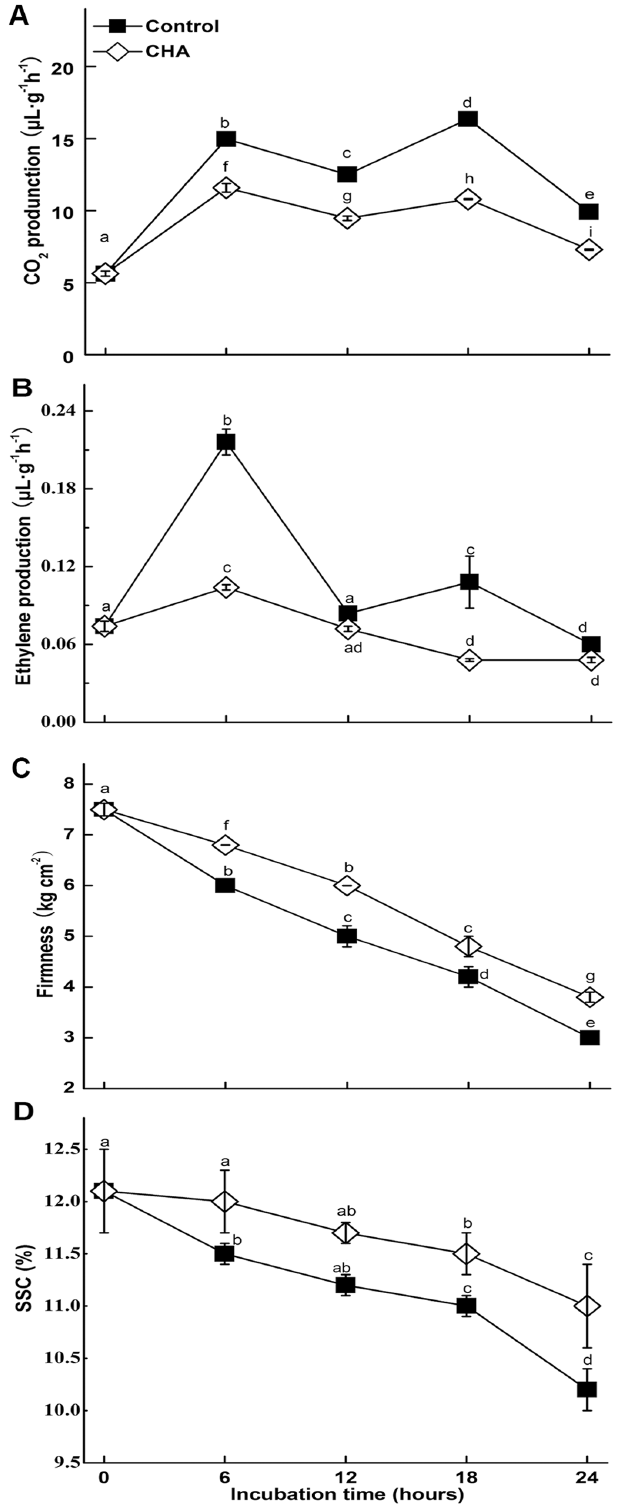
Fig 2. Effects of CHA on apple pulp discs incubated at 25°C. Each data point represents a mean ± standard deviation (for respiration rates and ethylene production, n = 3; for firmness and SSC, n = 6). Values with different letters are significantly different at p <